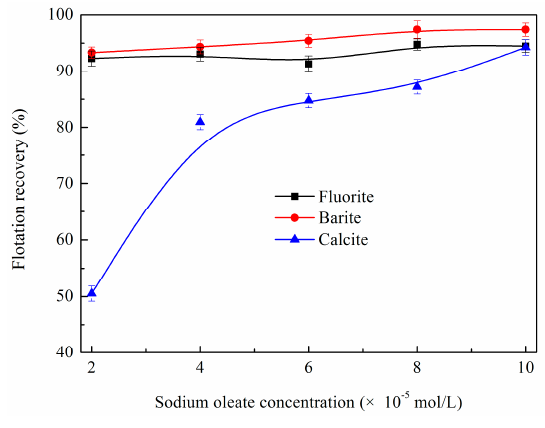
Figure 2. Effects of sodium oleate dosage on flotation recovery (pH = 7).